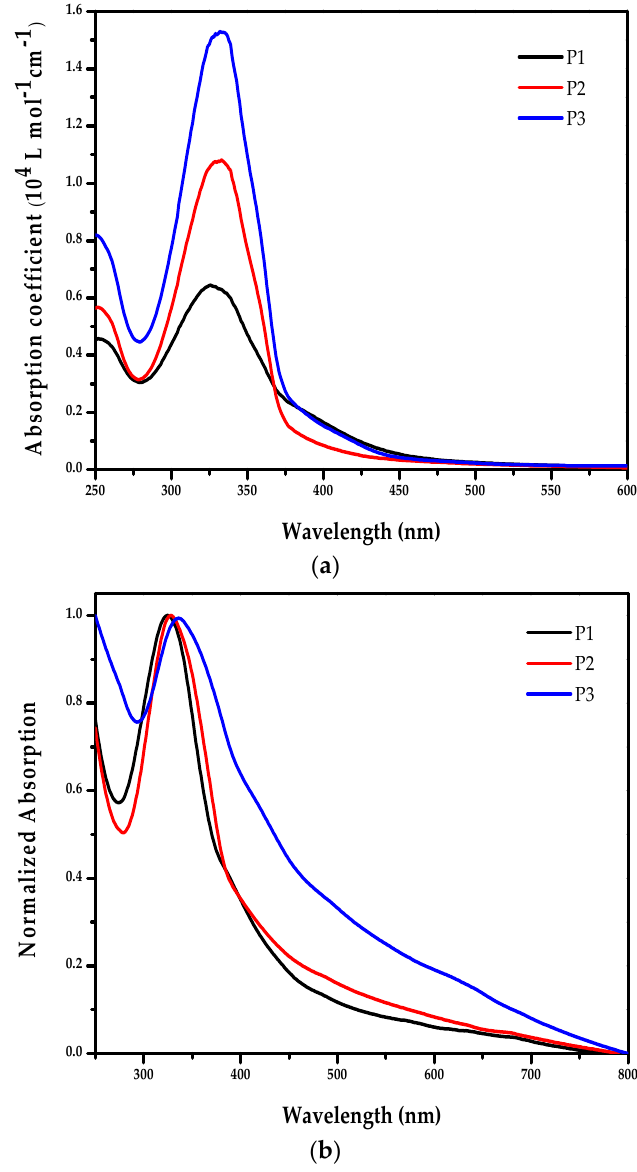
Figure 2. UV-Vis absorption spectra of P1, P2 and P3 in chloroform solution (10 − 5 mol L − 1 ) ( a ) and thin film ( b ). Table 1. Optical, thermal and electrochemical properties of P1, P2 and P3.